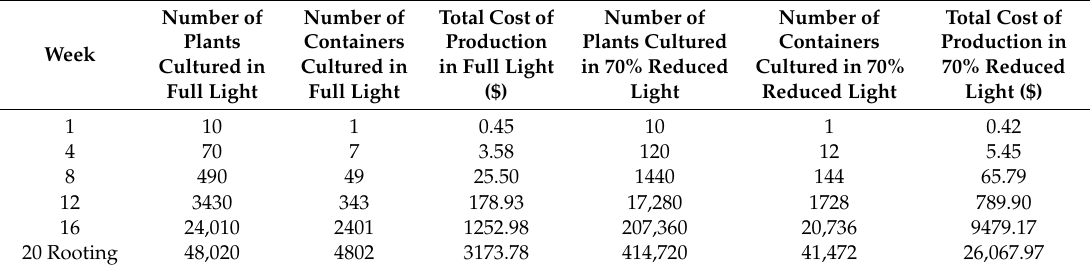
Table 6. Number of plants during following weeks and plantlet cost in normal and limited light conditions.